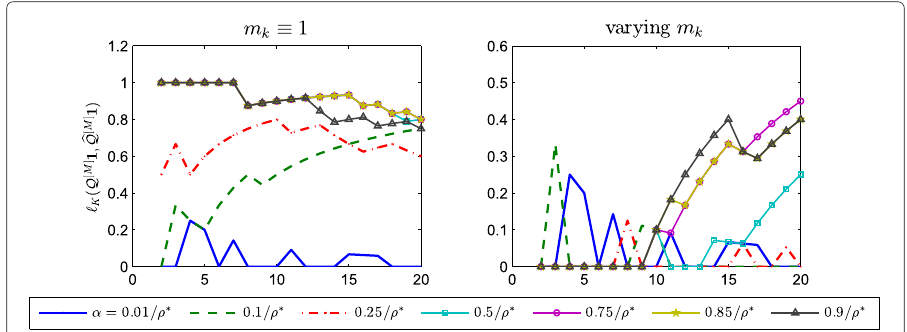
(cid:4) (cid:5) Q [ M ] 1 , (cid:12) Q [ M ] 1 versus K , for different choices of the downweighting